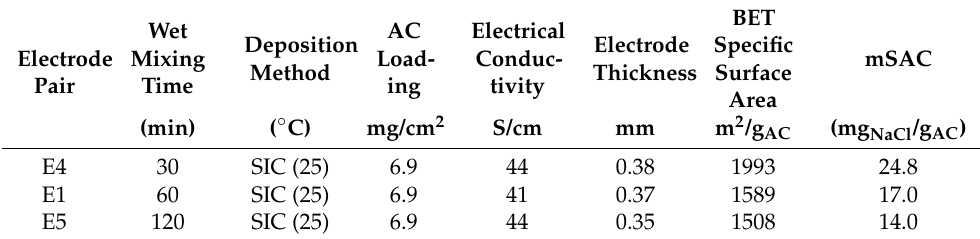
Table 2. Electrodes were produced using slurry infiltration by calendering (SIC) and were